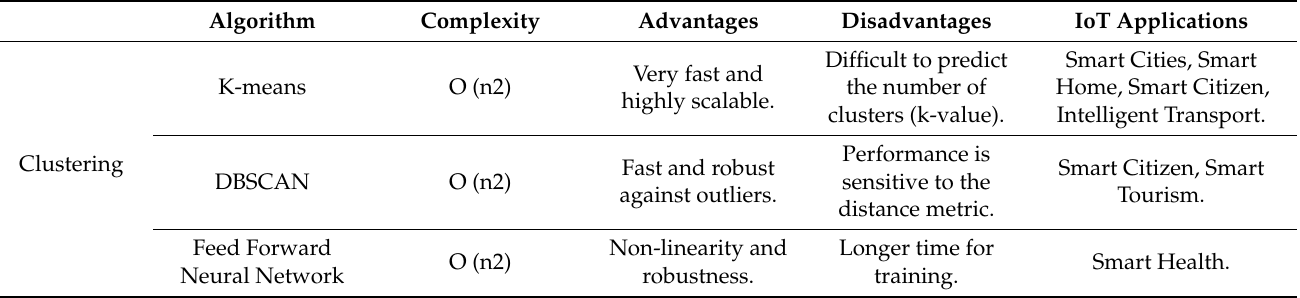
Table 12. Summary of Clustering